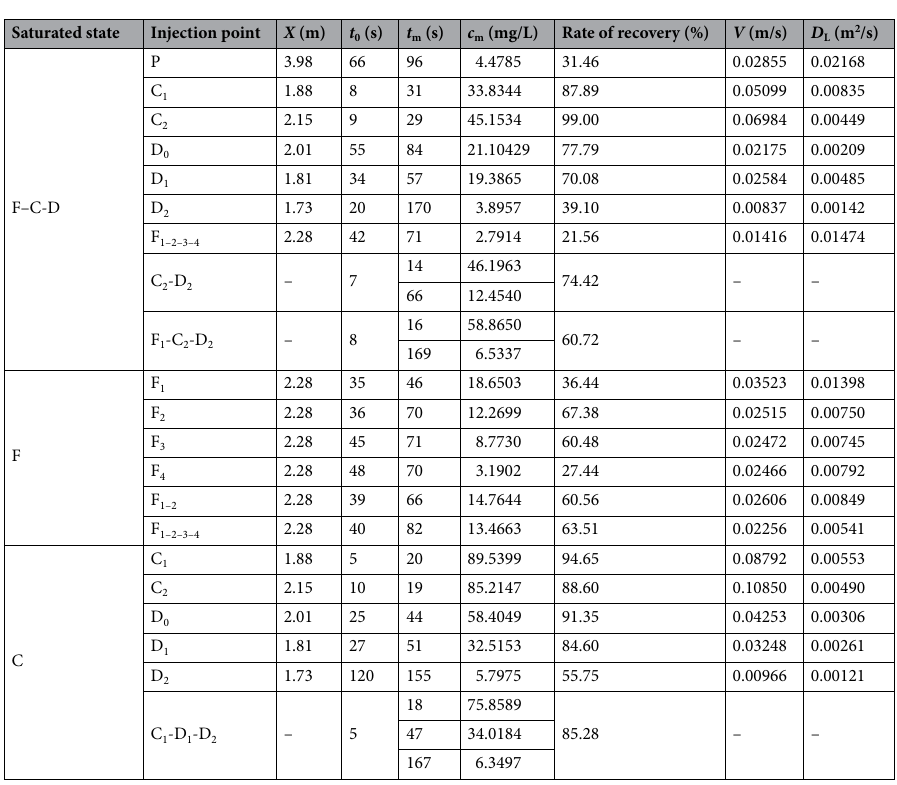
Table 1. Characteristic parameters of solute transport in fissures–conduits saturated flow.